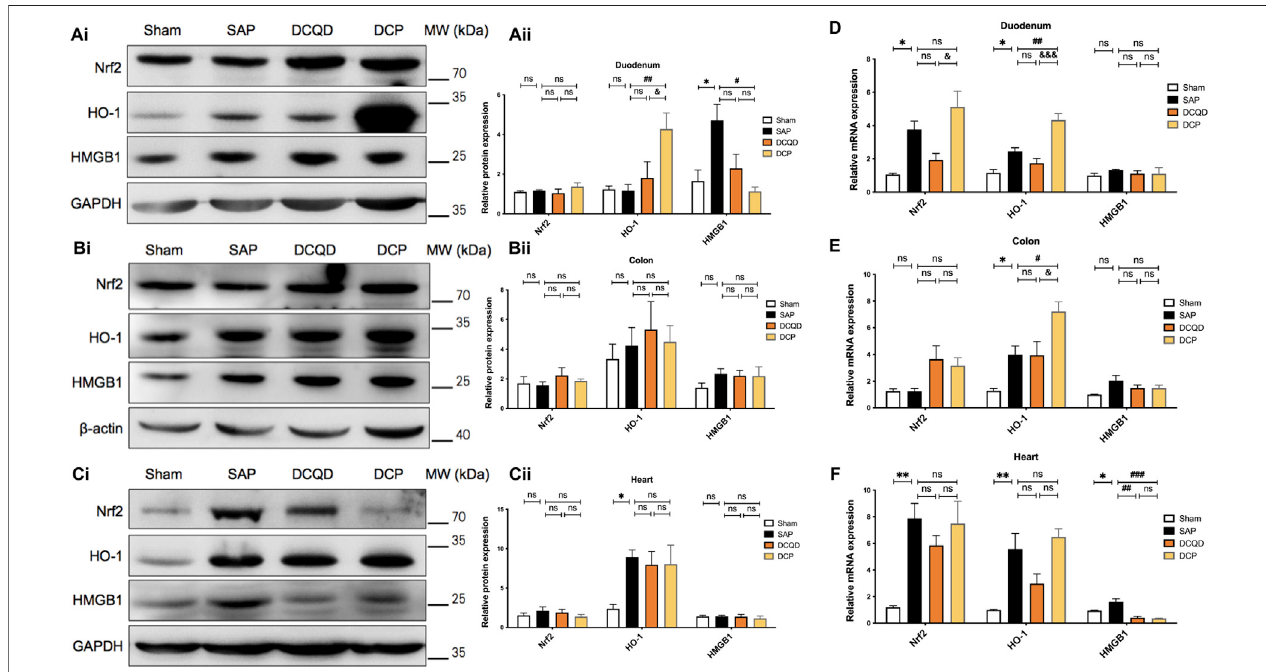
FIGURE5| DCPregulatedtheNrf2/HO-1/HMGB1signalingpathwaysinintestinalandcardiactissuesofratswithSAP. (A – C) :WesternblotanalysisofNrf2,HO-1 and HMGB1 protein expression in the duodenum, colon, and heart (Ai,Ci) and corresponding grayscale statistics (Aii,Cii) . Organs from rats in DCQD (9.6 mg/kg.BW) treatmentgroupwasincludedasacontrol.lane1,sham;lane2,SAP;lane3,DCQD(control);lane4,DCP. (D – F) :RT-PCRdetectionofNrf2,HO-1,andHMGB1mRNA expression in the rats ’ organs in each group. The results are presented as the mean ± SEM. * p < 0.05, ** p < 0.01 vs. sham group, # p < 0.05, ## p < 0.01, ### p < 0.005 vs. SAP group; & p < 0.05, &&& p < 0.005 vs. DCQD group; ns, p > 0.05. sham: sham operation group; SAP: Sever acute pancreatitis group; DCQD: Da-Cheng-Qi decoction treatment group; DCP: Dao-Chi powder treatment group.